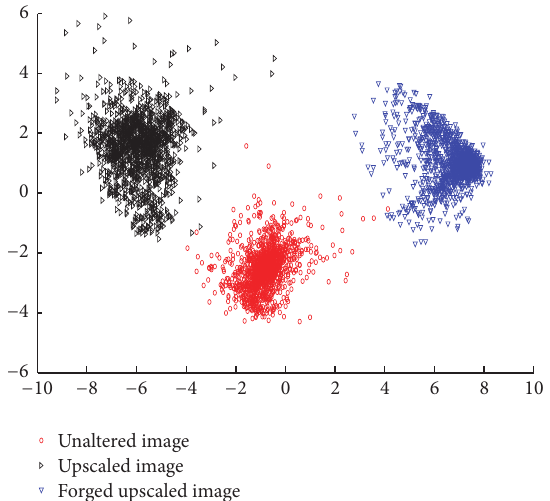
Figure 9: ROC curves of detecting resampled and forged resampled image (“ALL”) from unaltered image under uncompressed